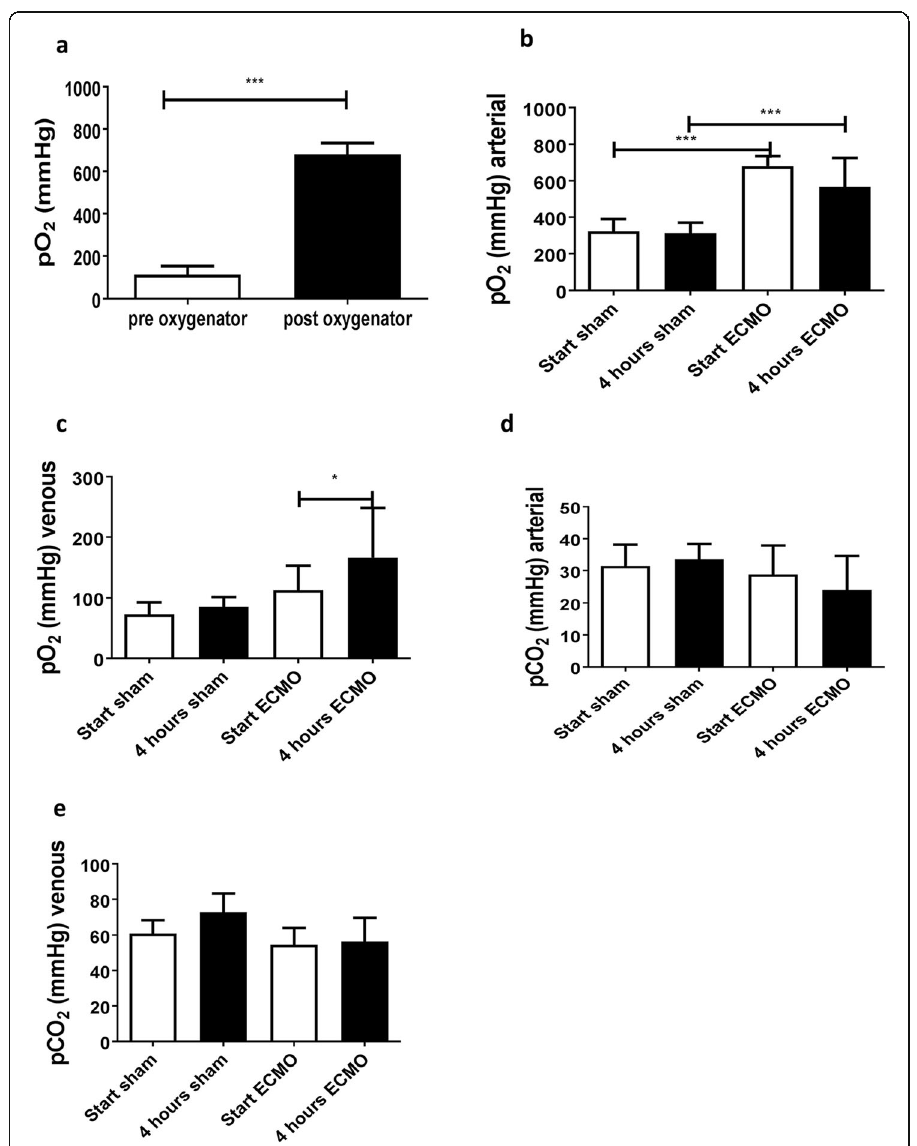
Fig. 5 Blood gas analysis (BGA) was performed to ensure proper function of the oxygenator ( a ). pO 2 ( b , c ) and pCO 2 ( d , e ) values were evaluated in the ECMO animals ( n = 8) and sham animals ( n = 6). All values are given as mean ± SD.* p < 0.05; ** p < 0.01, *** p < 0.0001, ns not